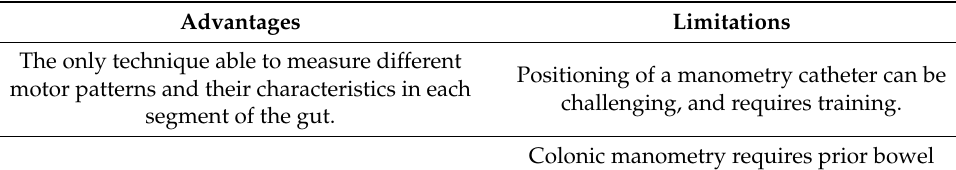
Table 8. Advantages and limitations of high-resolution manometry.